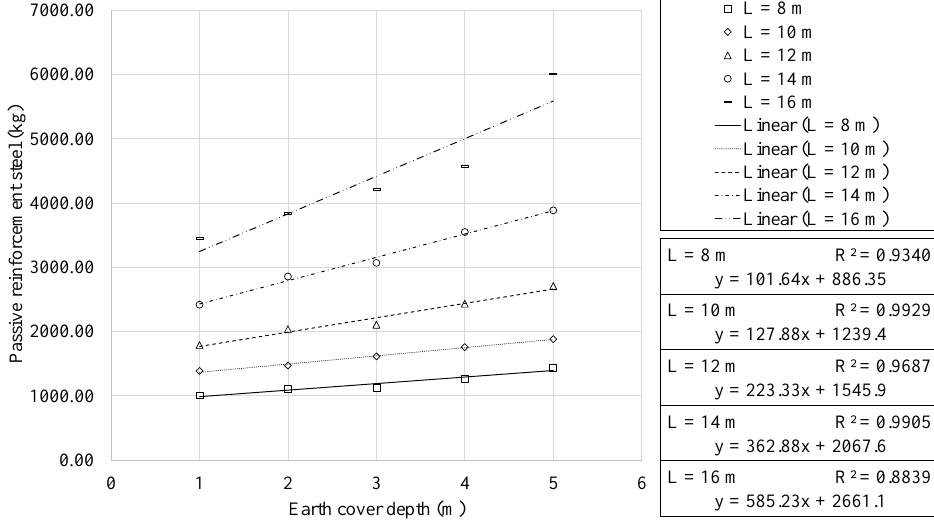
Figure 12. Passive reinforcement steel as function of earth cover depth, for each horizontal span. Similar to the behaviour highlighted for concrete volume, quadratic and linear re- lationships are observed with the span and earth cover, respectively. Furthermore, the results showed a clear trend towards using a specific steel grade. This led to 91.11% of the optimal RMHFs using B500S steel for the passive reinforcement. The regression analysis obtained expressions with R2 correlation coefficients close to one. A one meter increase in the earth cover leads to an increase in steel use of 101.64 and 585.23 kg for the 8 and 16 m span RMHFs, respectively. As stated in Section 1, the final cost of the structure is a direct leads to an increase in the final cost of EUR 144.32 and 831.02 per linear meter, respectively. Similar to that mentioned for concrete use, the increase in steel necessary is also related to higher energy consumption and CO 2